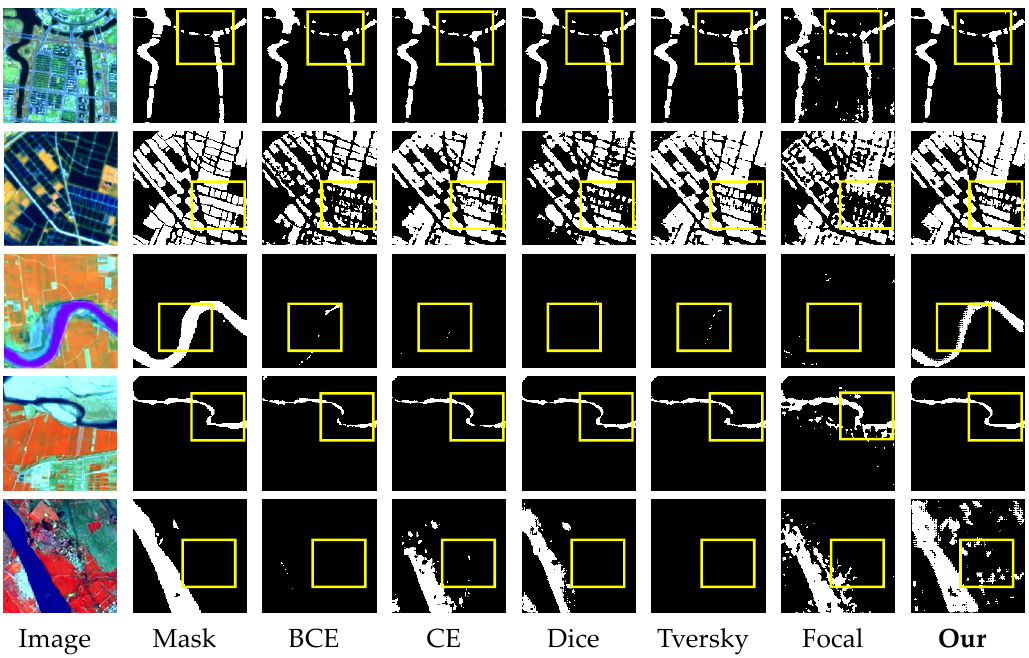
Figure 17. Example of SegNet network segmenting water bodies using 6 different loss functions.